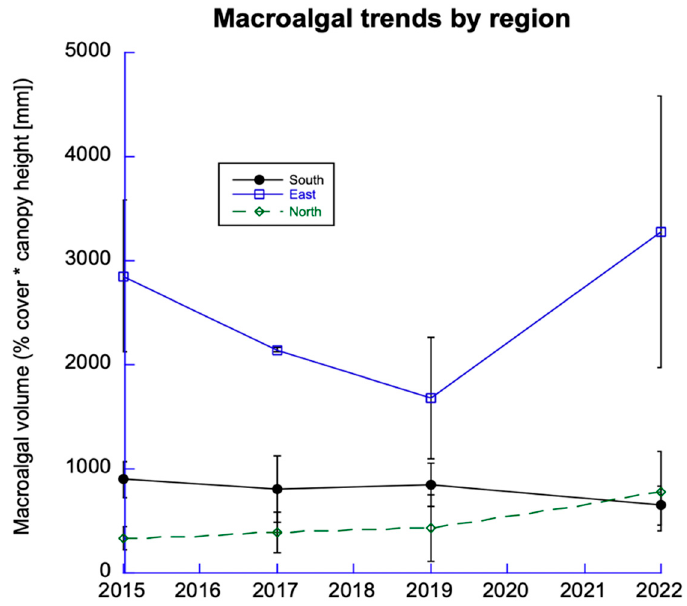
Figure 5. Trends in macroalgae. Data from 12 sites among 6 DR regions from the 3 sectors. Juvenile corals are important for the recovery of damaged coral reefs. While there has been no net change in the abundance of juvenile corals since 2015 in the East and South Sectors, the North Sector has shown a consistent decline since 2017 (Figure 6).